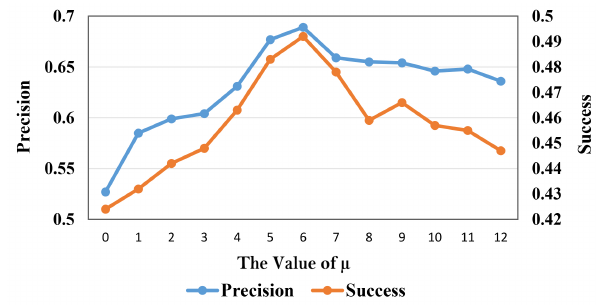
Figure 12. Effect of µ on the performance of ALCF.